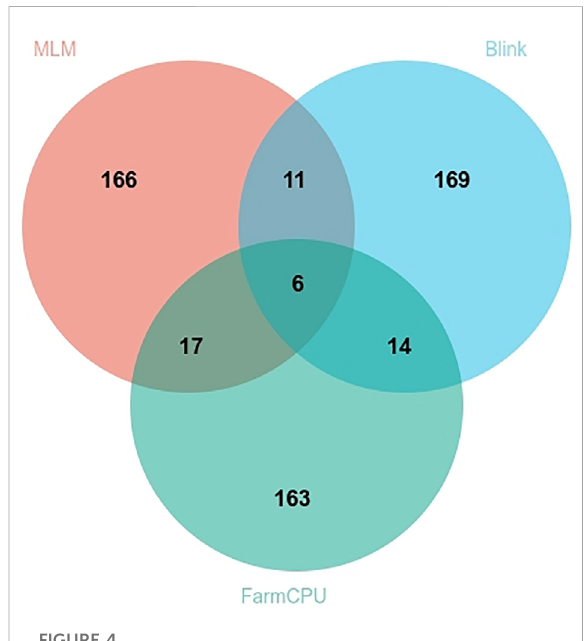
FIGURE 4 Venn plot based on the top 200 signi fi cant sites obtained from different statistical models.